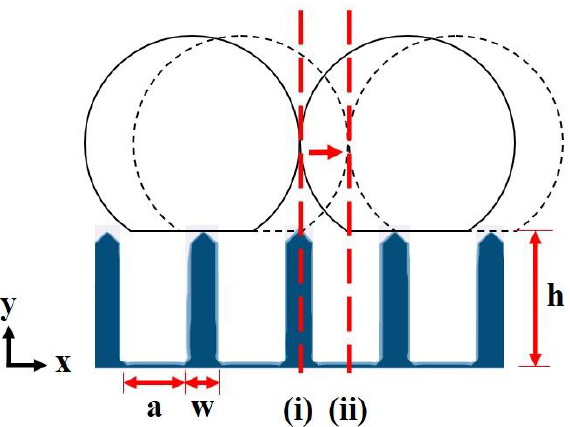
Figure 7. Schematic diagram of the refined textured surface with pointed pillars (structure height h = 15 lattice, gap a = 7 lattice, pillar width w = 3 lattice). The mutual tangent line is initialized from position (i) to (ii) in different cases.